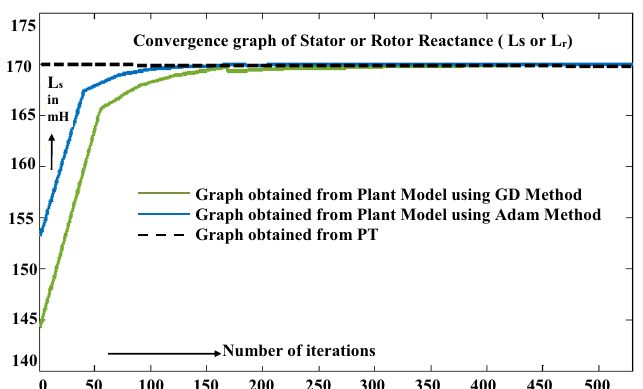
Fig. 12 Convergence of BPANN based estimation of L s with GD, ADAM